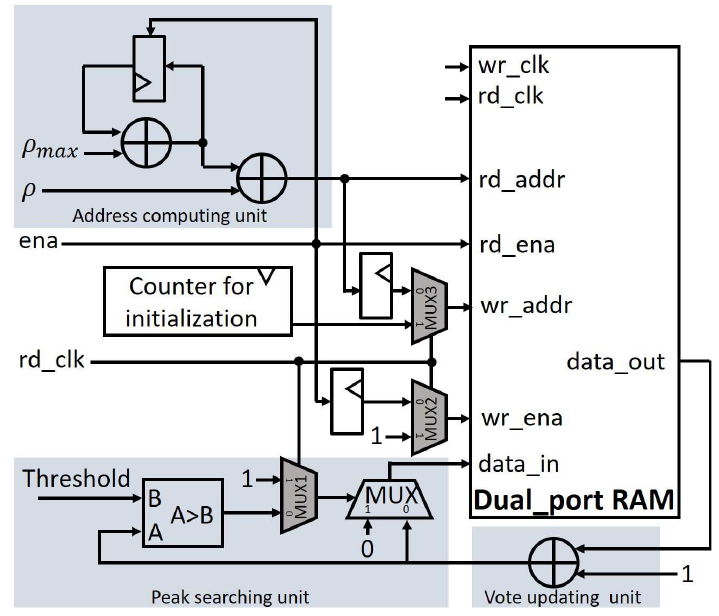
Figure 3. One of the parallel modules for implementing the Hough space by dual-port memory with a pipelined voting